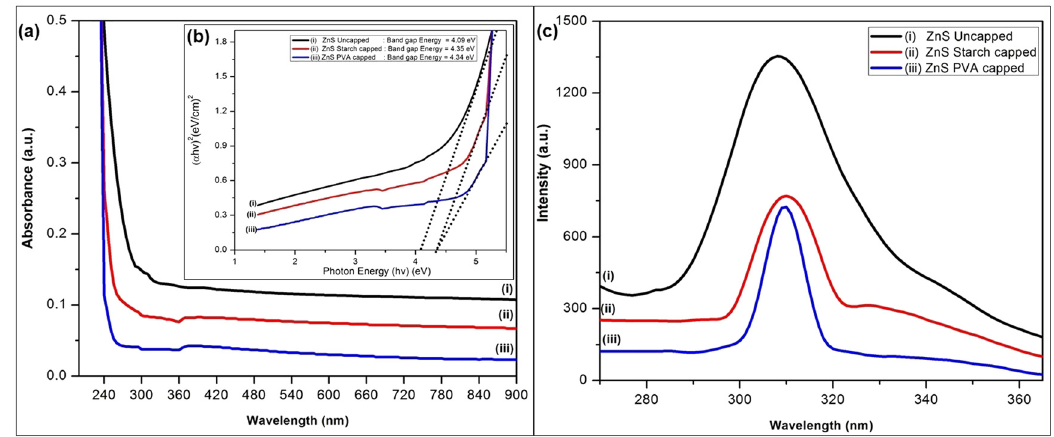
Figure 1: Absorption ( a ) , Tauc plot ( b ) , and emission spectra ( c ) of ZnS uncapped ( i ) , starch - ( ii ) , and PVA - ( iii ) capped